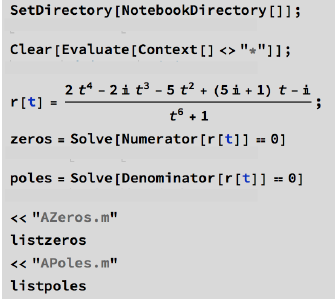
Figure 40. Part of the structure that allows the computation of the zeros and poles of r